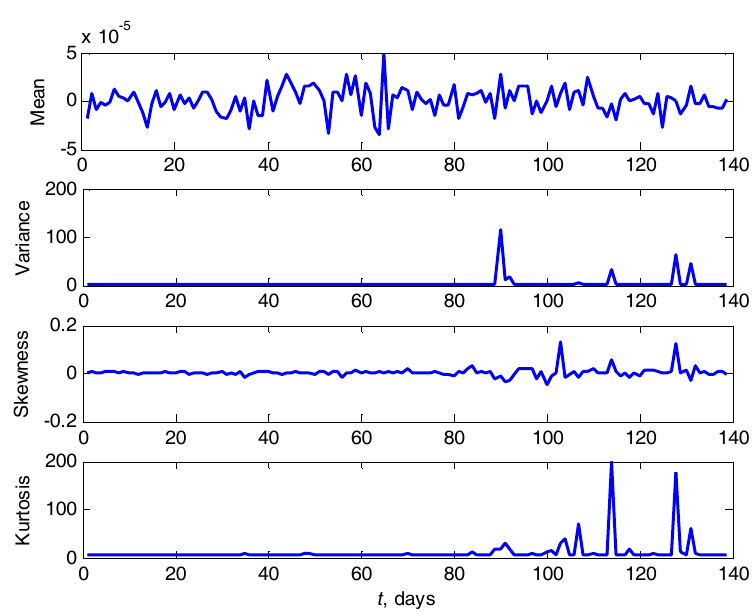
Figure 15. Statistical-based features: mean, variance, skewness and kurtosis calculated from D3 signal of wavelet decomposition.